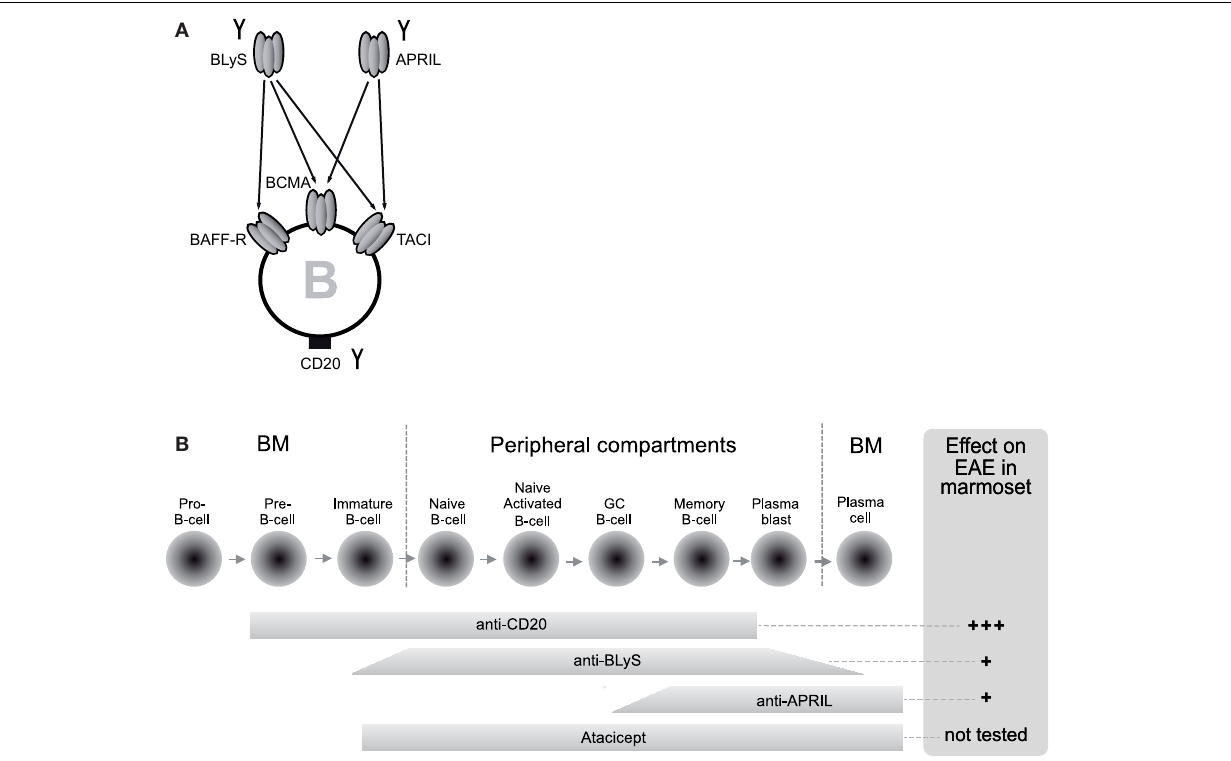
FIGURE 1 | Differential mechanisms and distinct EAE outcome of B-cell directed therapies. (A) B-cell targeting therapies tested in the marmoset EAE model are neutralizing monoclonal antibodies (mAbs) against BLyS and APRIL and a depleting mAb against CD20 (indicated with the symbolY). BLyS and APRIL are related cytokines expressed by myeloid and lymphoid cells with a specific action on B cells. B cells express three types of receptors;